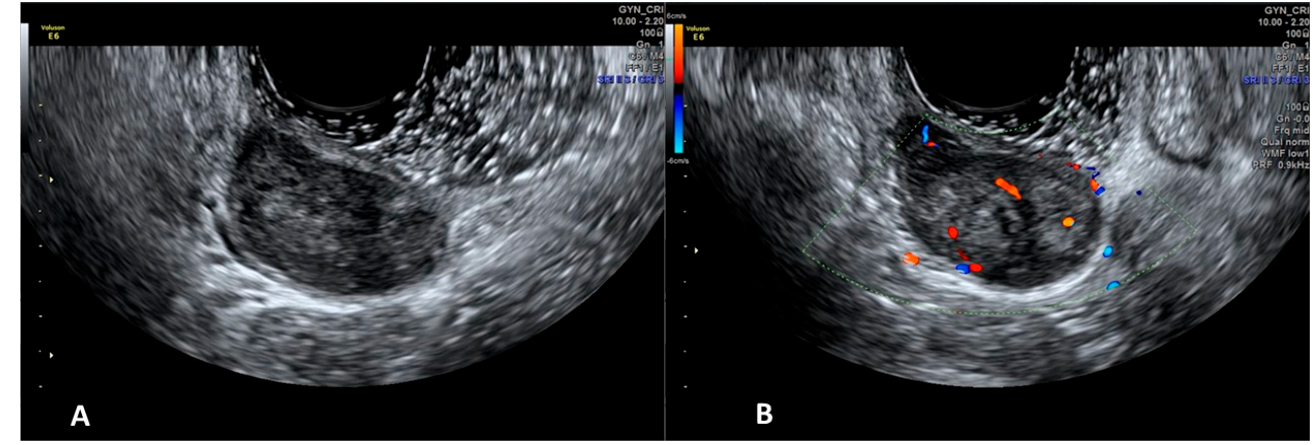
Figure 2. SVG image of a vaginal leiomyoma (Panel ( A )) an its vascularization (Panel ( B )). Vaginal Stenosis